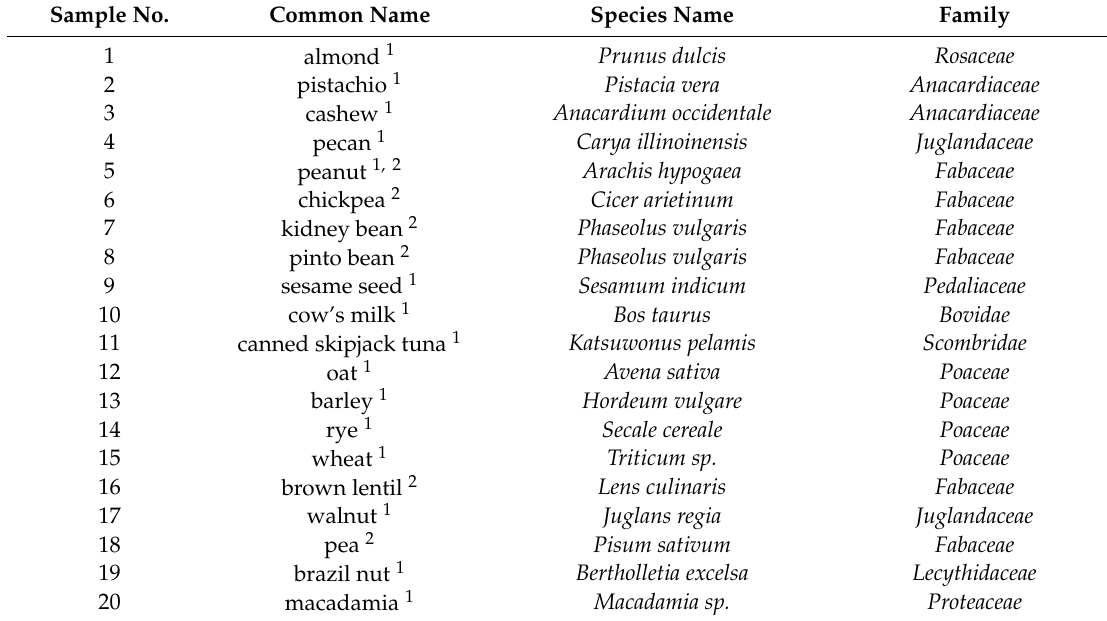
Table 1. Food samples used in this